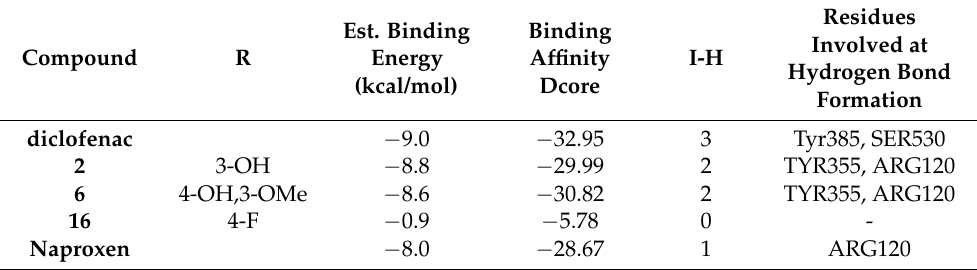
Table 4. COX2: PDBID: 1PXX binding